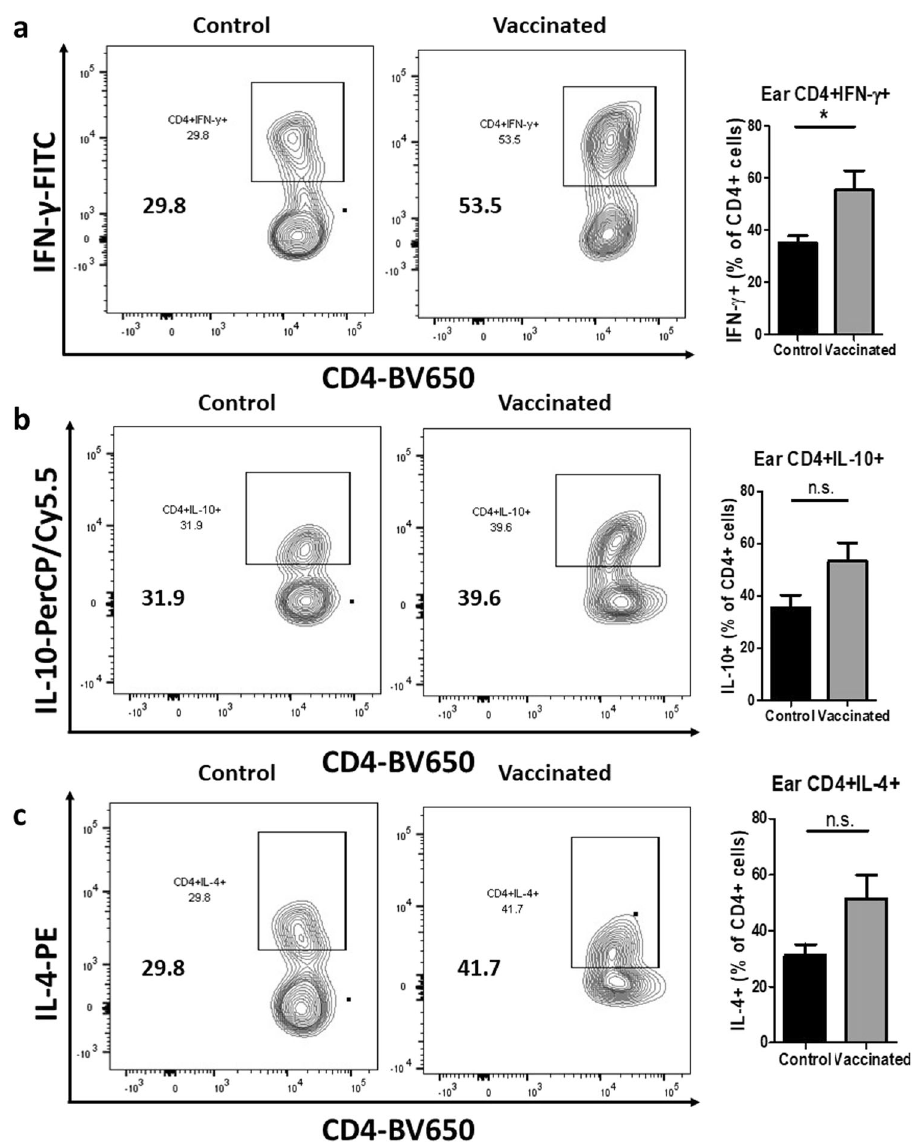
Fig. 9 LmexCen − / − immunization mediates an enhanced Th1 response in C57BL/6 ears challenged with Lmex WT. a Percentage of CD4 + IFN- γ + T cells in the ear of vaccinated and control mice at 14 wpc analyzed via fl ow cytometry. b Percentage of CD4 + IL-10 + T cells in the ear of vaccinated and control mice at 14 wpc analyzed via fl ow cytometry. c Percentage of CD4 + IL-4 + T cells in the ear of vaccinated and control mice at 14 wpc analyzed via fl ow cytometry. Data show one representative experiment out of two independent experiments and show mean ± SEM, N = 5 for each group at each time point. Unpaired two-tailed Student ’ s t -test was performed to compare statistical signi fi cance. A P -value < 0.05 was considered signi fi cant. In all panels * represents P ≤ 0.05, ** represents P ≤ 0.01, and *** represents P ≤